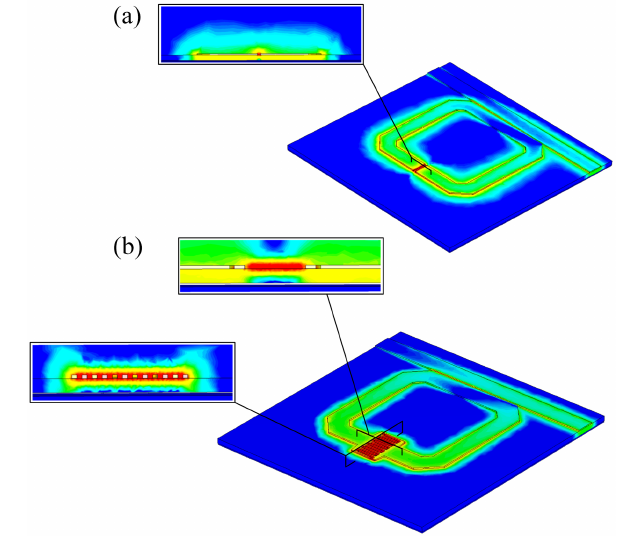
Figure 12. Electrical field in the cross section of the split capacity for a simple split (a) and interdigital structure (b) .